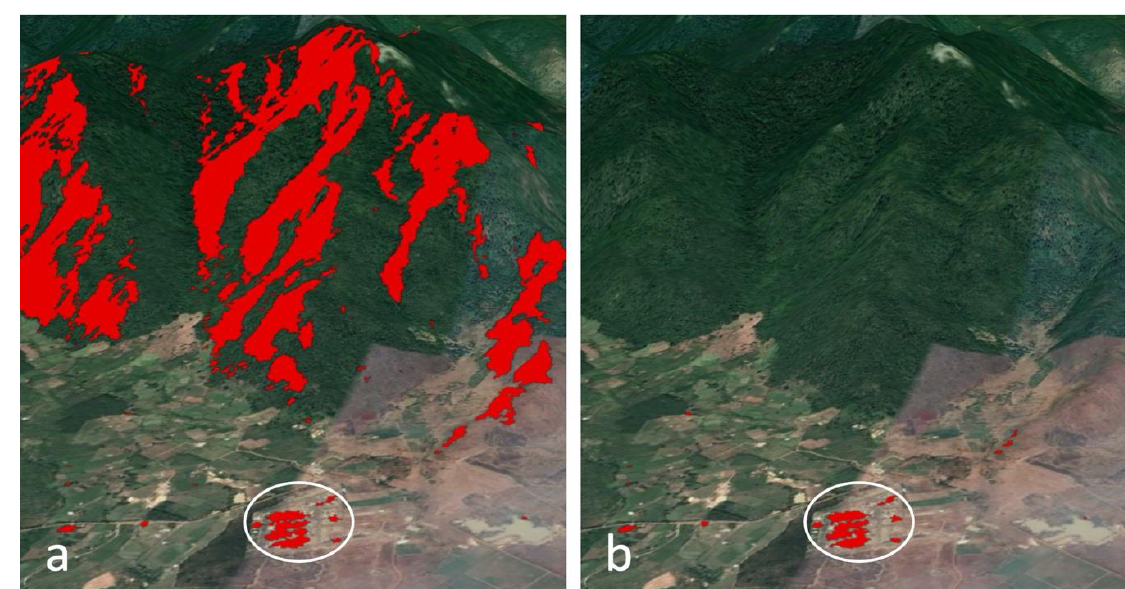
Figure 5. Detection of building structures (red areas) in an area around Hàm Cần Mountains without geomorphon correction ( a ), and with geomorphon correction ( b ). The ellipse marks a small settlement area (6.4 hectares) in Lò To Village where a built area was identified on the relatively flat terrain about 0.5 km from the foothill. The building structure map was overlayed on the topography using Google Earth Pro in a three-dimensional view.